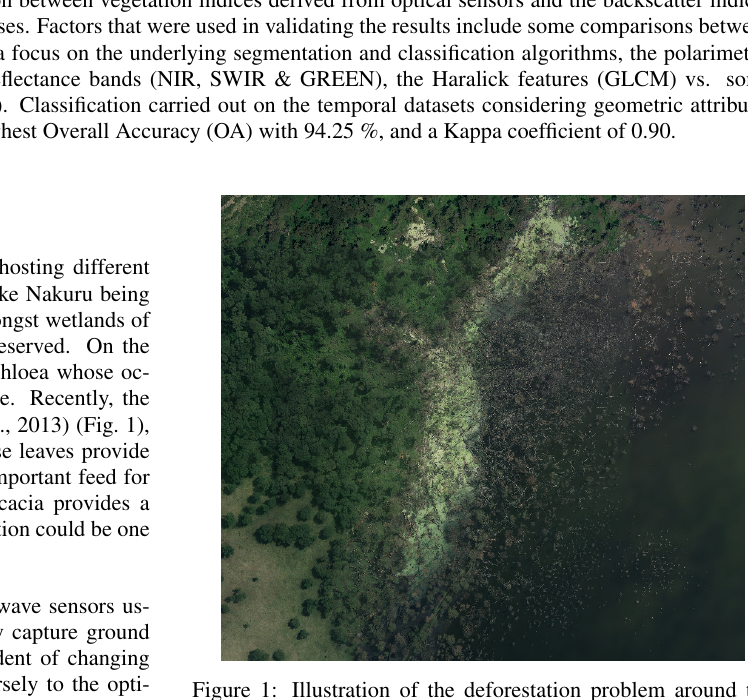
Figure 1: Illustration of the deforestation problem around the Nakuru